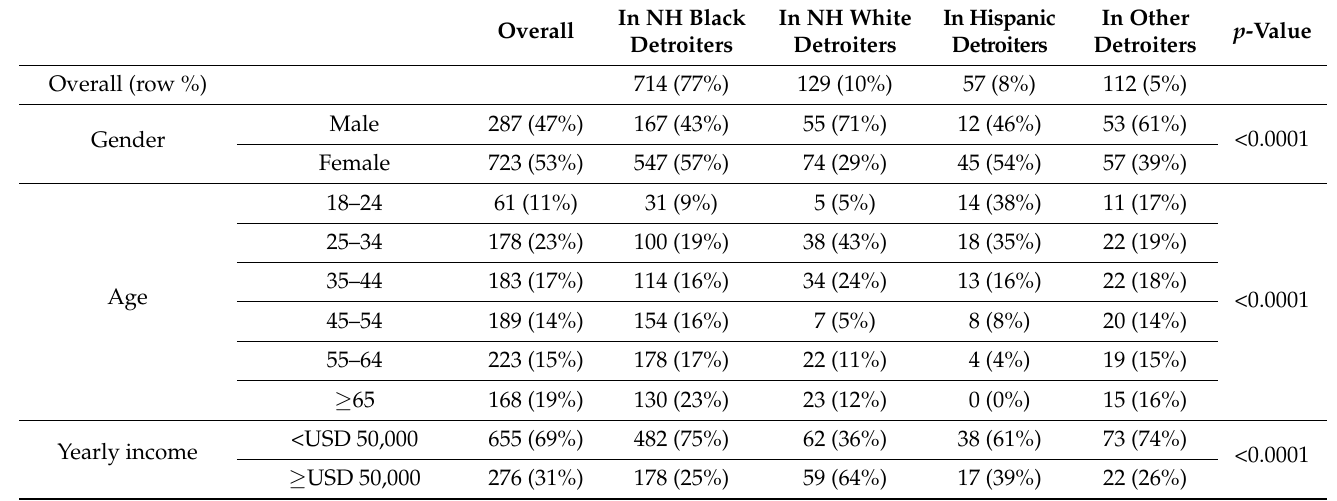
Table 1. Demographic characteristics, COVID-19 experiences, trust in healthcare providers and authorities, and vaccination intent, stratified by race/ethnicity, Detroit Metro Area Community